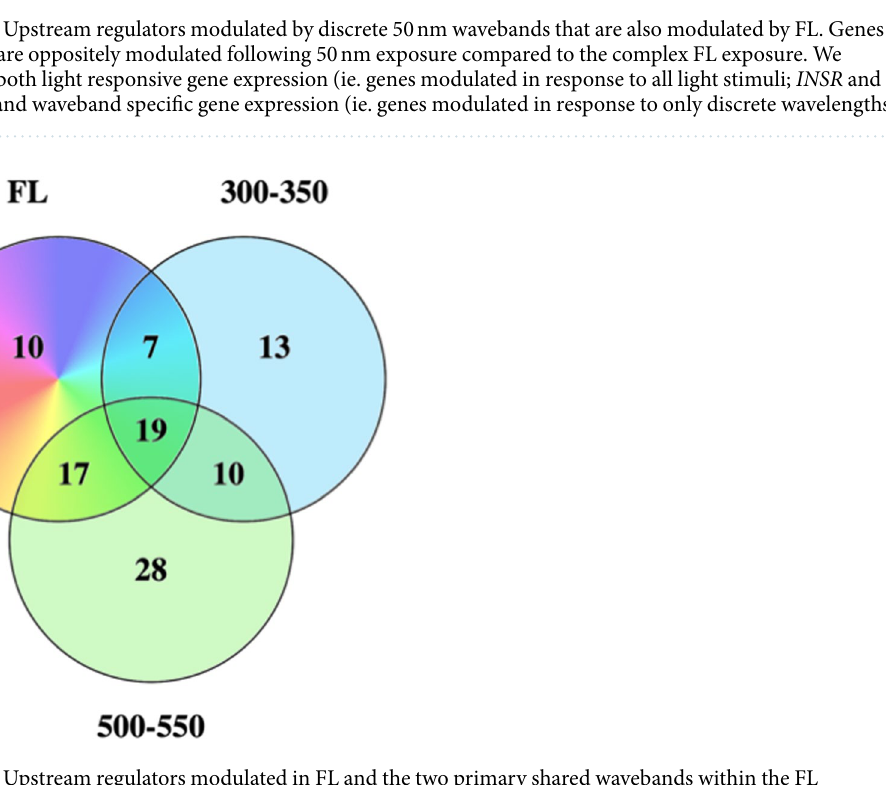
IL-1 mediated inhibition of RXR and the ILK and calcium signaling pathways were all up-modulated. Zebrafish